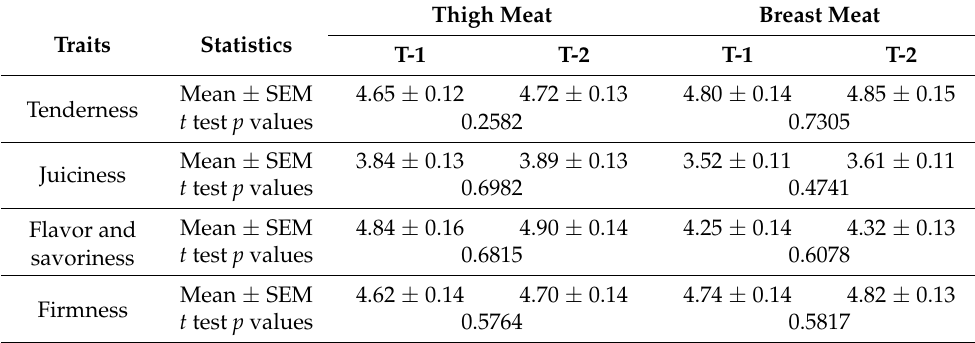
Table 9. Sensory scores of thigh and breast